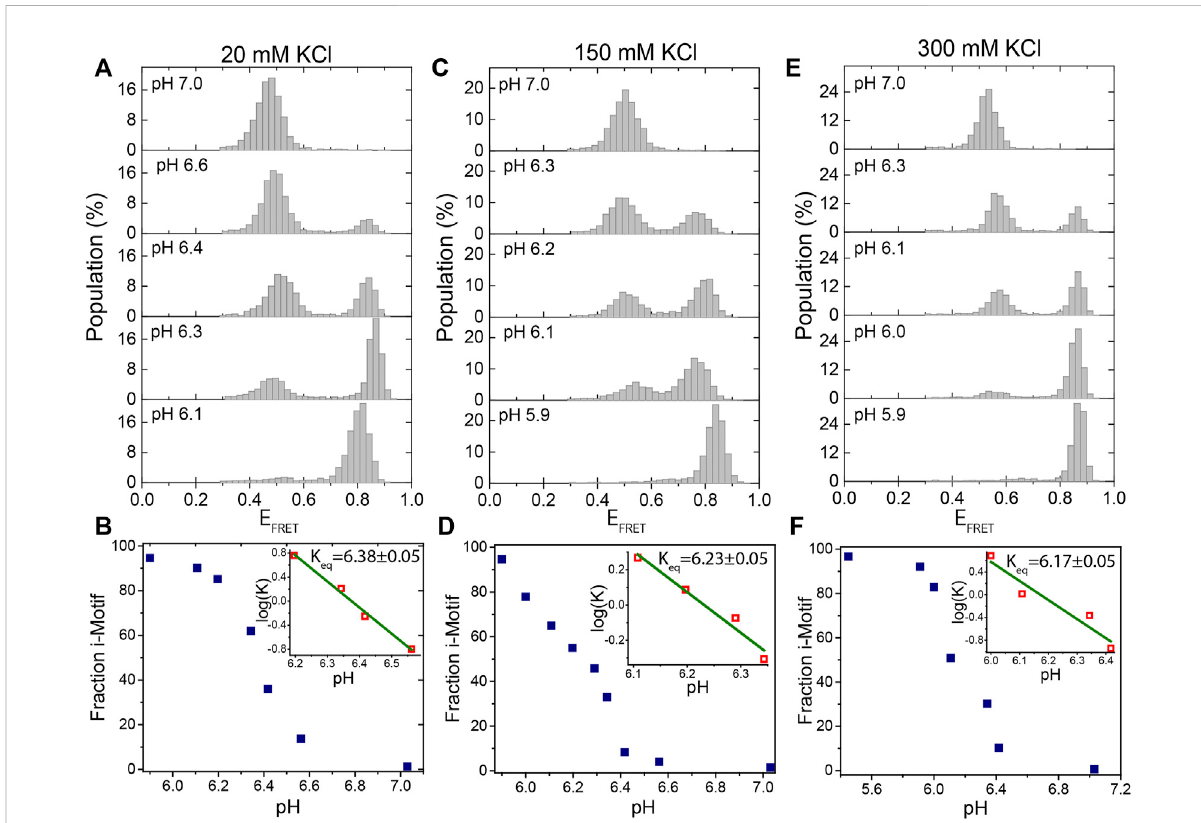
FIGURE 2 TitrationofpHata fi xedKClconcentration. (A,B) at20 mMKCl; (C,D) at150 mMKCl;and (E) - (F) at300 mMKCl.ThepHwastitratedfrom7.0to 5.9 at each of these KCl concentrations. Under all of these ionic conditions, the DNA molecules are exclusively unfolded at pH 7.0 and exclusively folded at pH 5.9. We observe two peaks at intermediate pH levels, around 6.3, which represent the folded or unfolded states. The evolution of the fraction of i-motif molecules as a function of pH is depicted in (B) , (D) , and (F) . The green lines in the inset are linear fi ts to the most rapidly varying segments of the of the curve of log ( K ) vs. pH